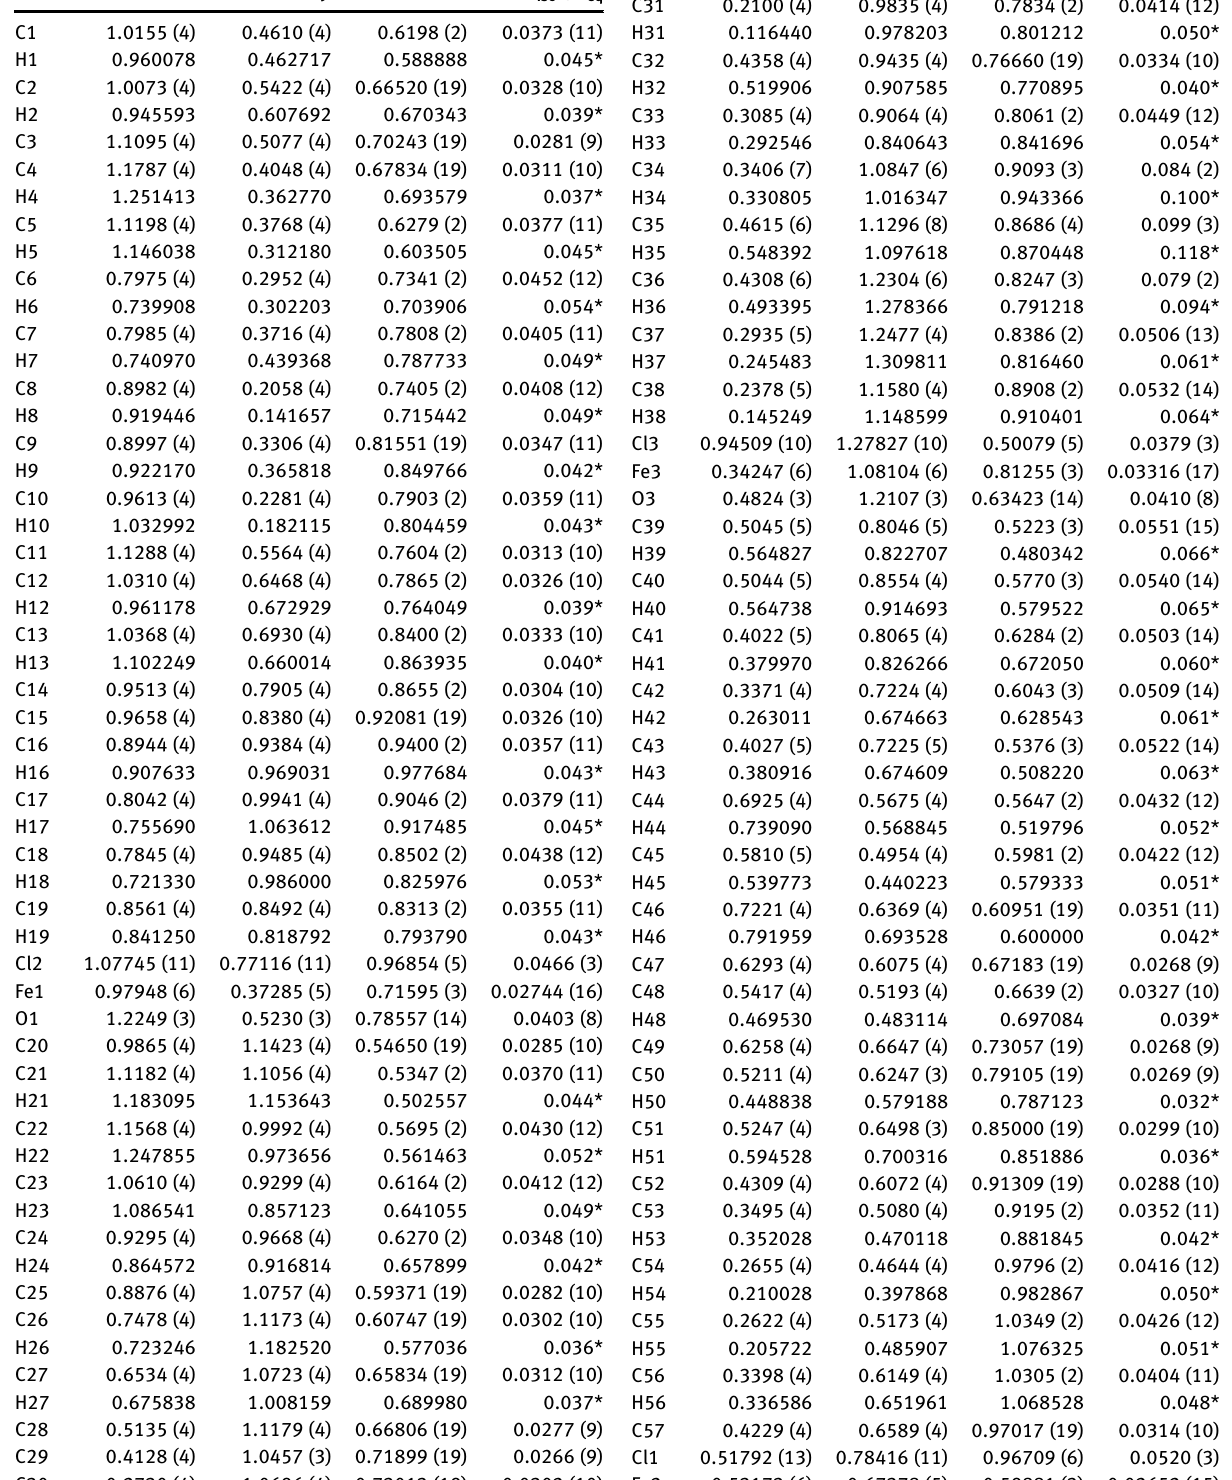
Table  : Fractional atomic coordinates and isotropic or equivalent isotropic displacement parameters (Å 